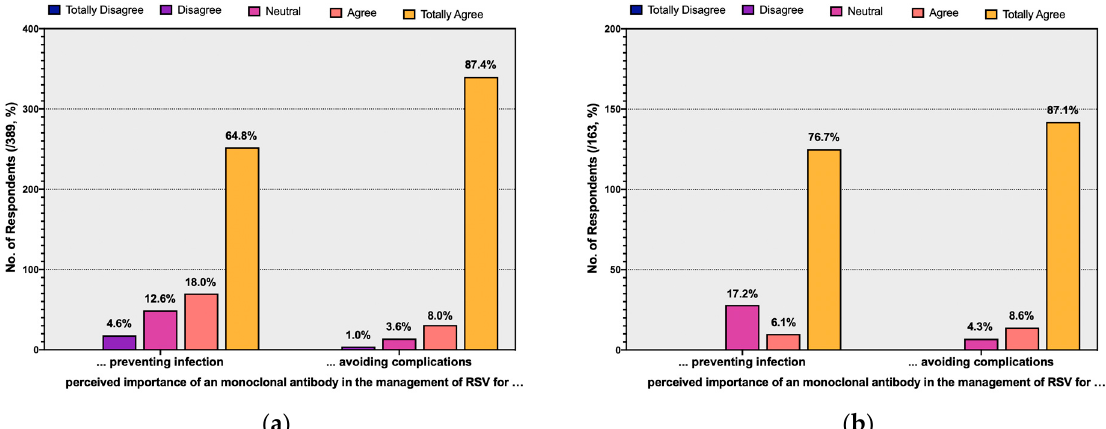
Figure 4. Ratings of the perceived importance of monoclonal antibodies in the management of respiratory tract infections by Respiratory Syncytial Virus (RSV) in terms of avoiding natural infections and its complications. Data are reported by including the sample as a whole ( a ), and only participants that had actually cared for RSV cases in the previous 5 years ( b ).